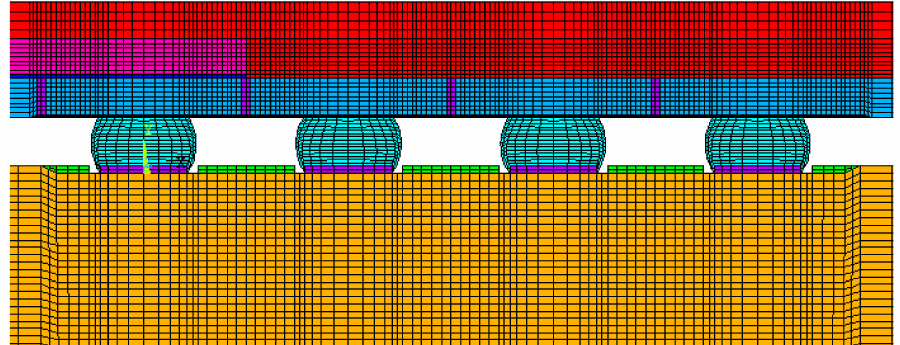
Figure 7. Two-dimensional (2D) finite element model of the FO-WLP.